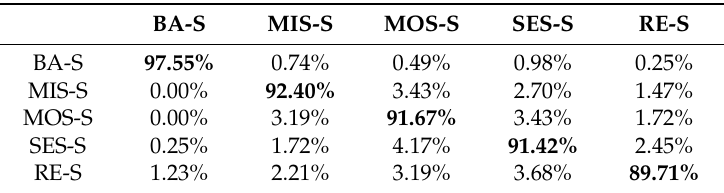
Table 4. Classification rates of K-ELM with SC features (SC + K-ELM).